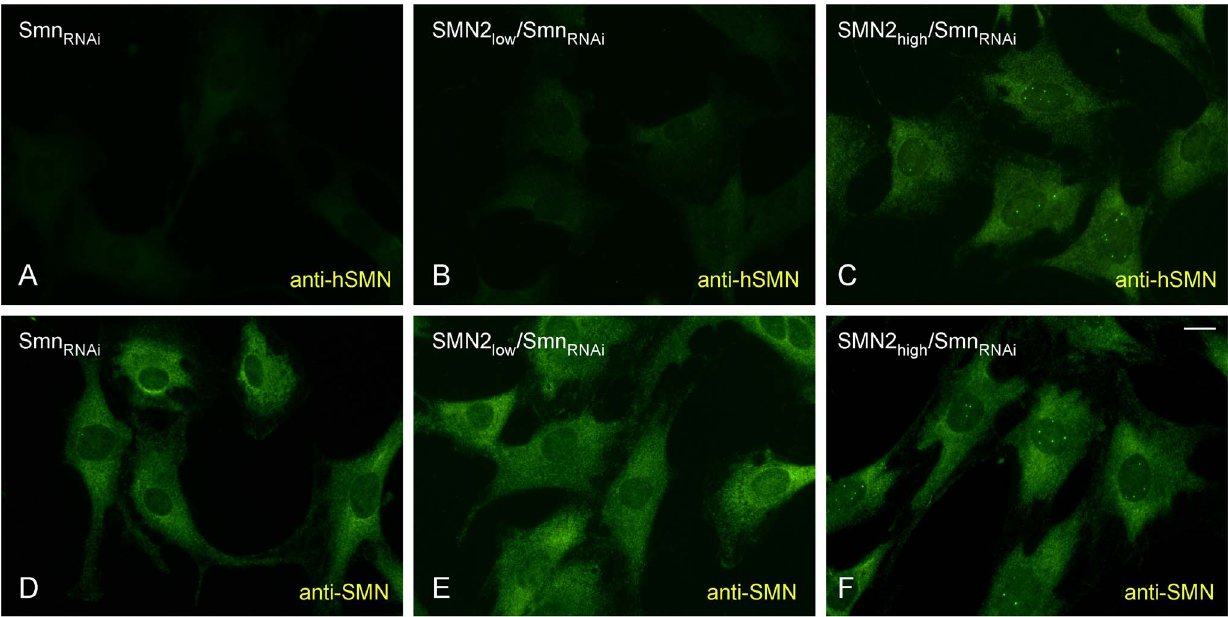
Figure 3. Subcellular localization of the human SMN protein in NIH3T3-SMN2/Smn RNAi cell lines. Indirect immunofluorescence and confocal microscopy analysis of NIH3T3-Smn RNAi (A and D), NIH3T3-SMN2 low /Smn RNAi (B and E) and NIH3T3-SMN2 high /Smn RNAi (C and F) cell lines using monoclonal antibodies specific to human SMN (hSMN, panels A–C) or both mouse and human SMN (SMN, panels D–F). Scale bar, 10 m m.